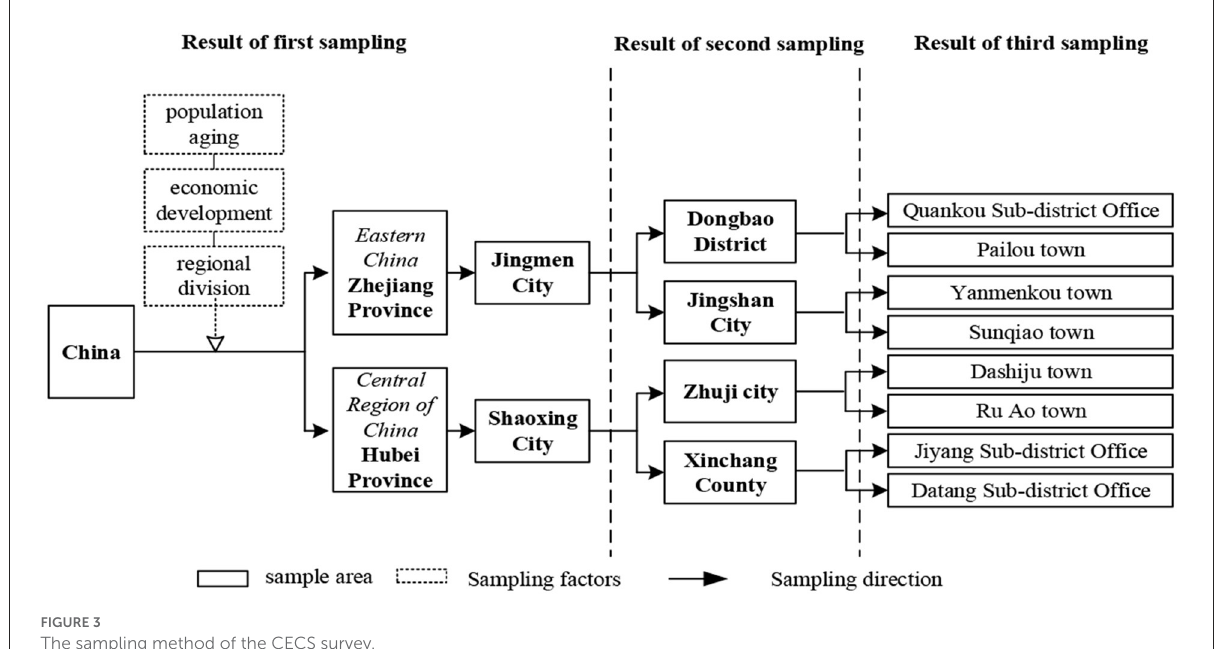
FIGURE3 The sampling method of the CECS